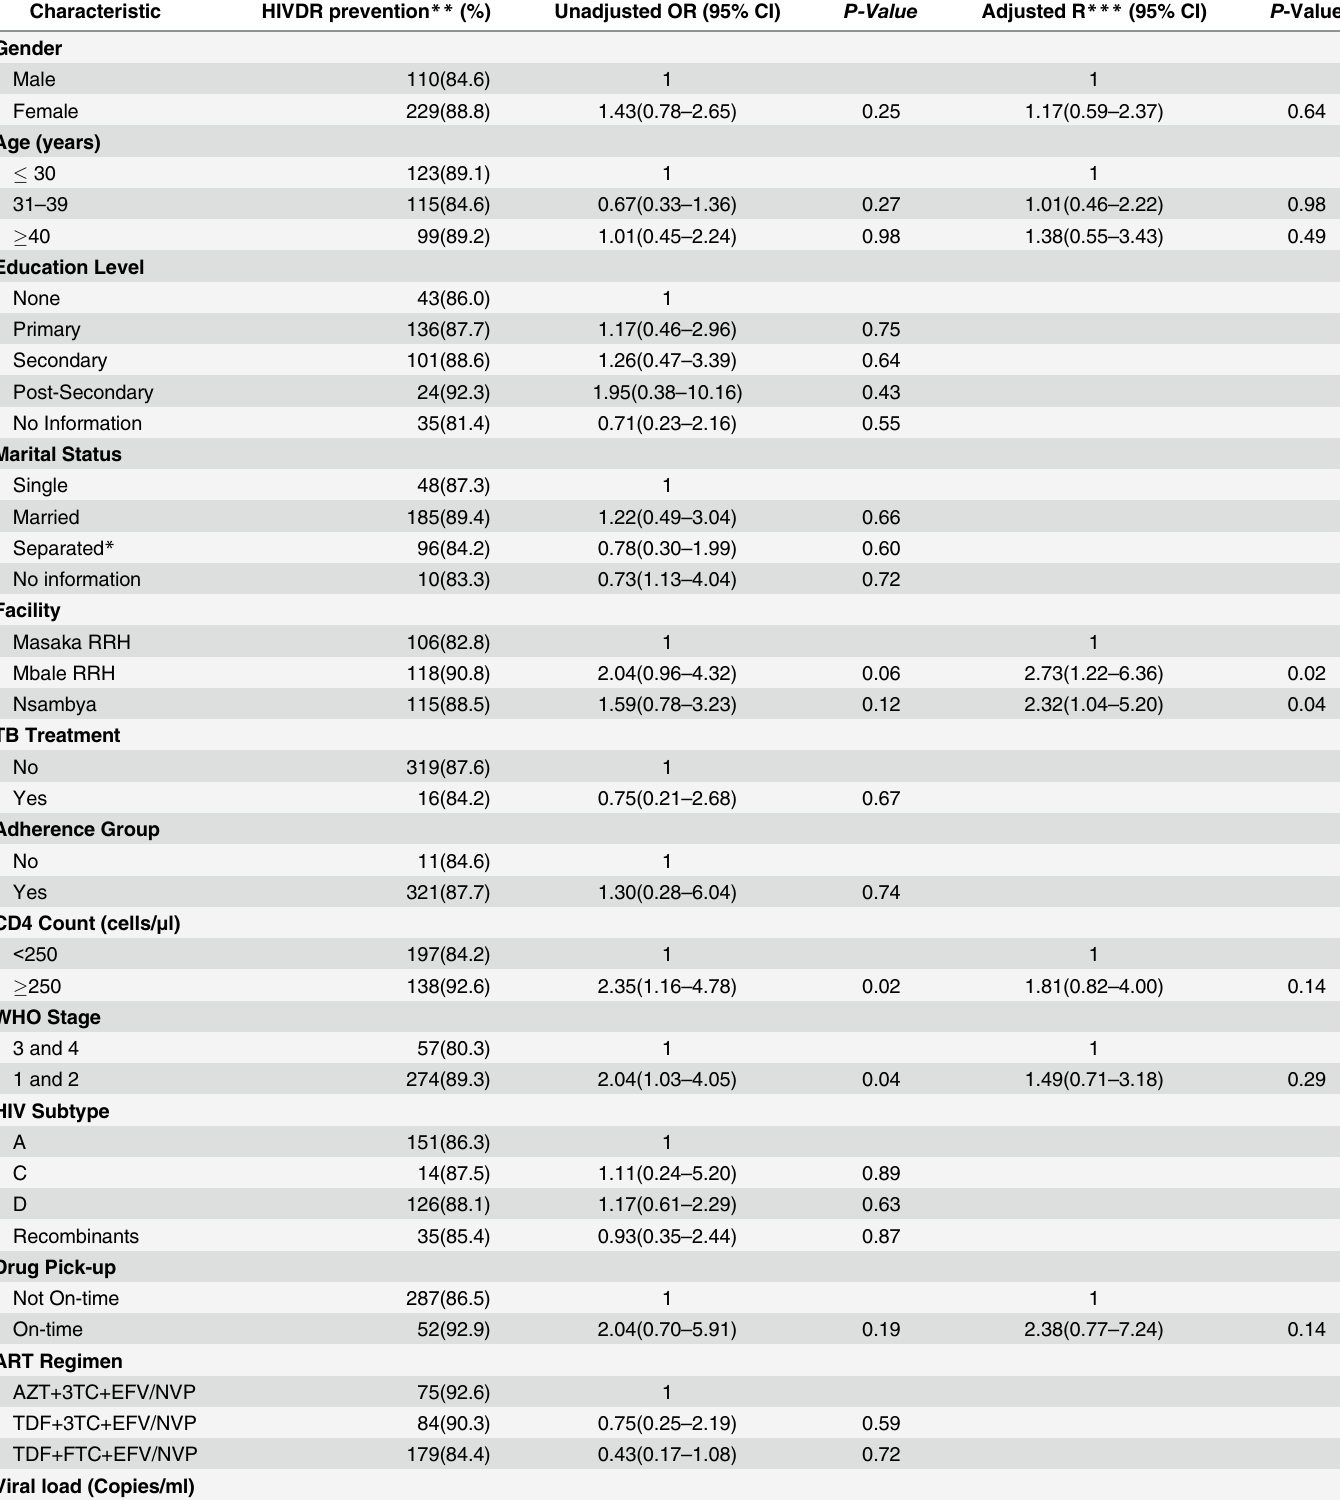
Table 3. Association between baseline patient characteristics and HIVDR Prevention at 12 Months after ART